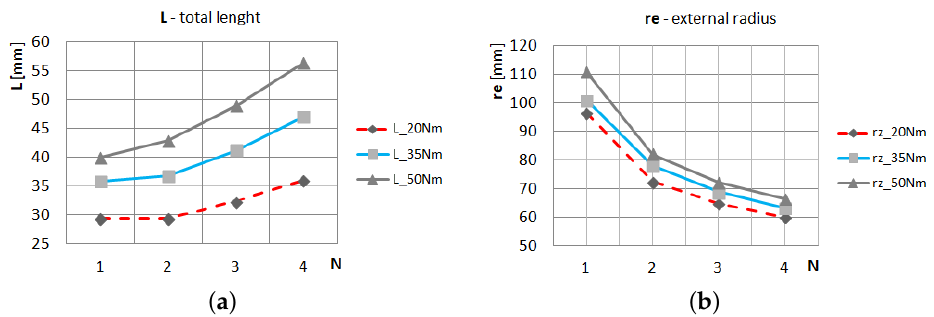
Figure 11. Total length vs. number of discs N ( a ) and external radius vs. number of discs N ( b ) for MR clutches T c = 20,35,50